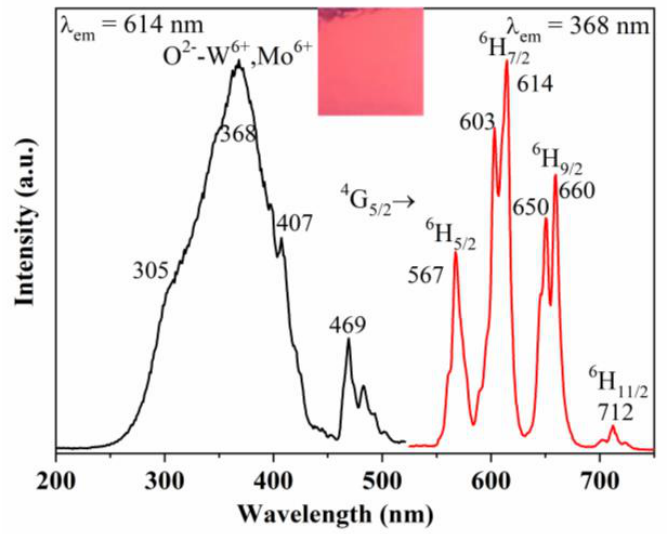
Figure 3. Photoluminescence (PL) excitation ( left part ) and emission ( right part ) spectra of 2 mol.% Sm 3+ doped Lu 2 MoWO 9 .